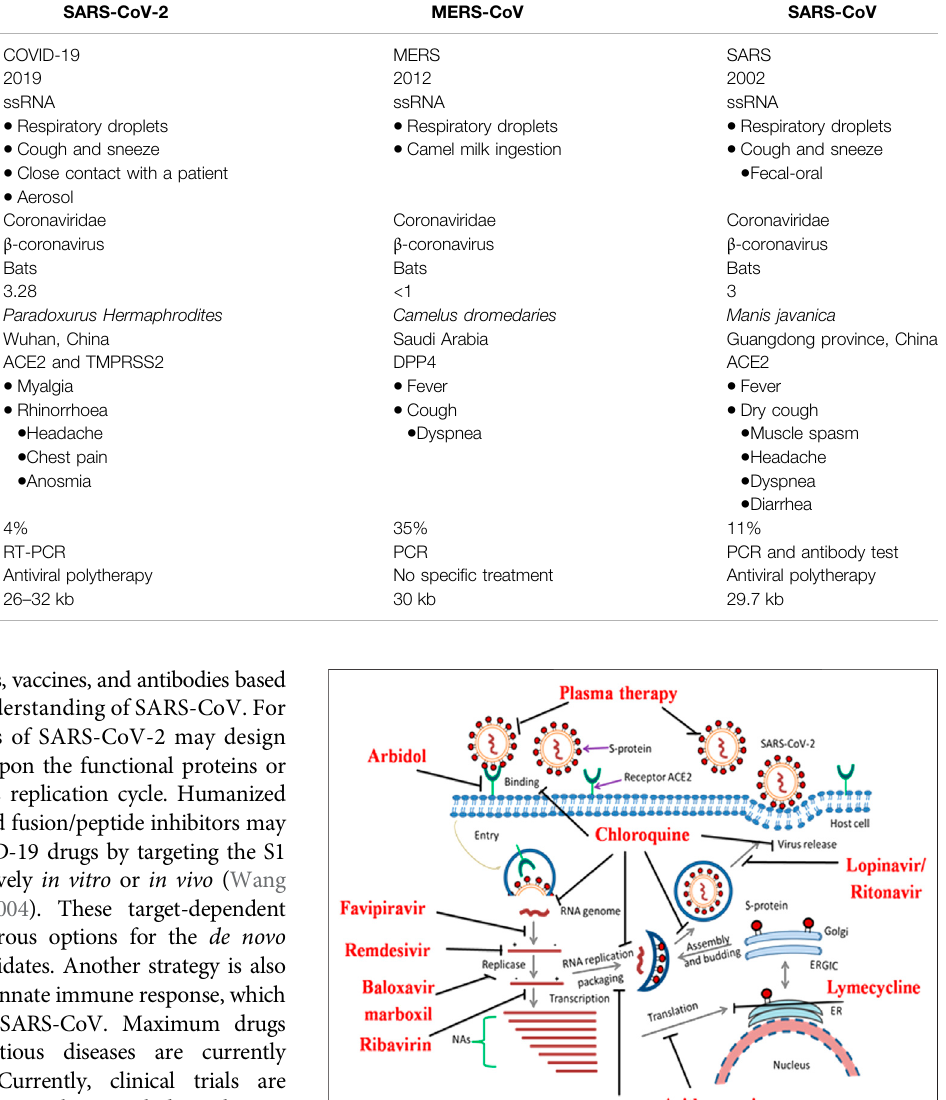
Natural reservoir